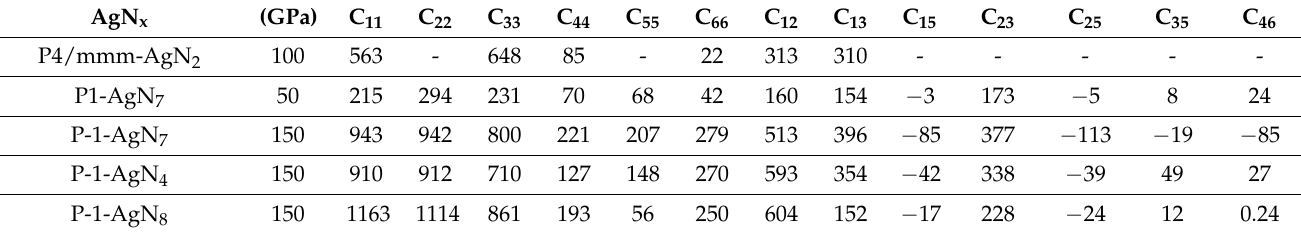
Table 1. The elastic constants Cij (GPa) of the Ag–N compounds at high pressure. AgN